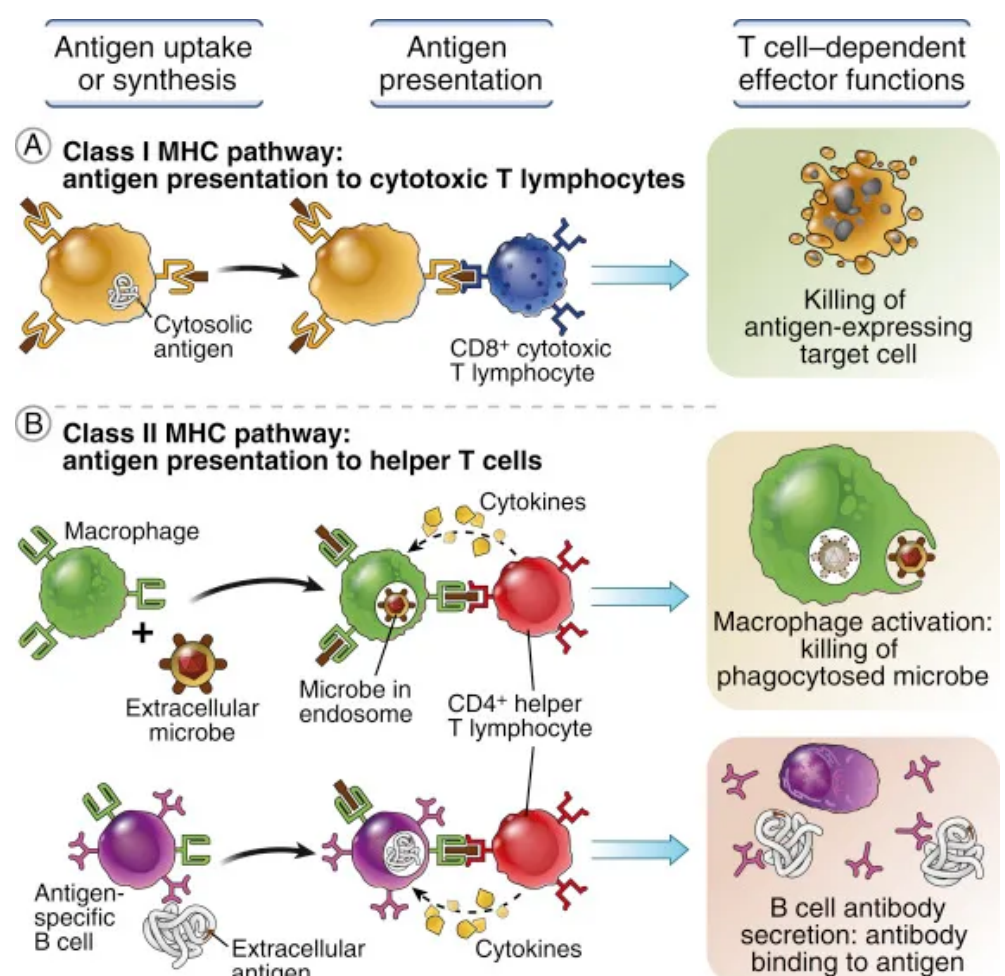
Figure 4. Antigen capture and presentation to lymphocytes.